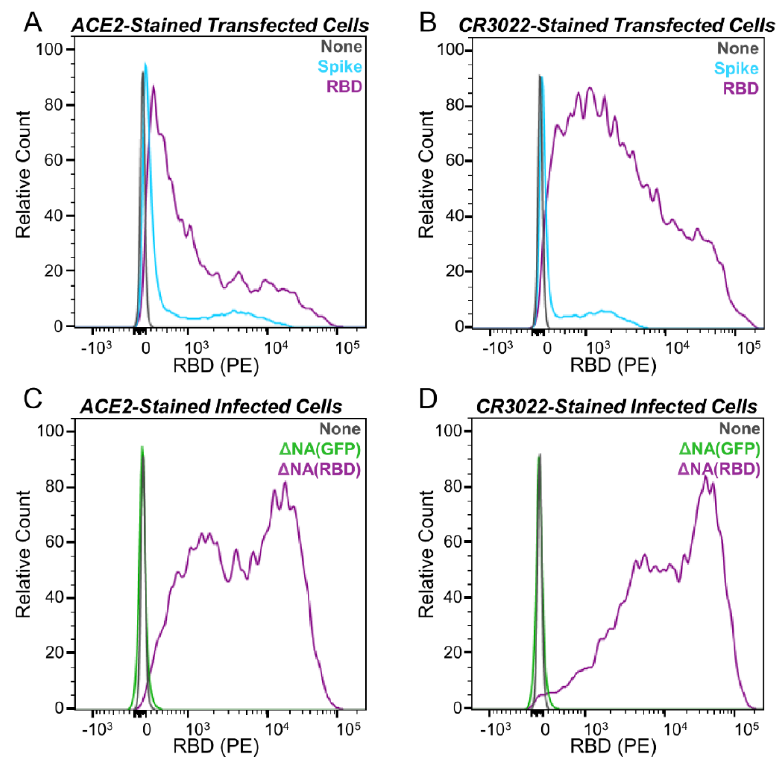
Figure 2. Infection with ∆ NA(RBD)-Flu leads to expression of RBD on the surface of 293T cells. Histograms, normalized to mode, of flow cytometry measurements showing RBD expression on the cell surface for: ( A ) Cells transfected with the mammalian expression plasmids HDM-SARS-Spike-delta21 or HDM_Spike_RBD_B7-1 and stained with ACE2 or ( B ) stained with CR3022 antibody, ( C ) Cells infected with ∆ NA(RBD)-Flu or ∆ NA(GFP)-Flu and stained with ACE2 or ( D ) CR3022 antibody. Data shown are from a single population of stained cells.